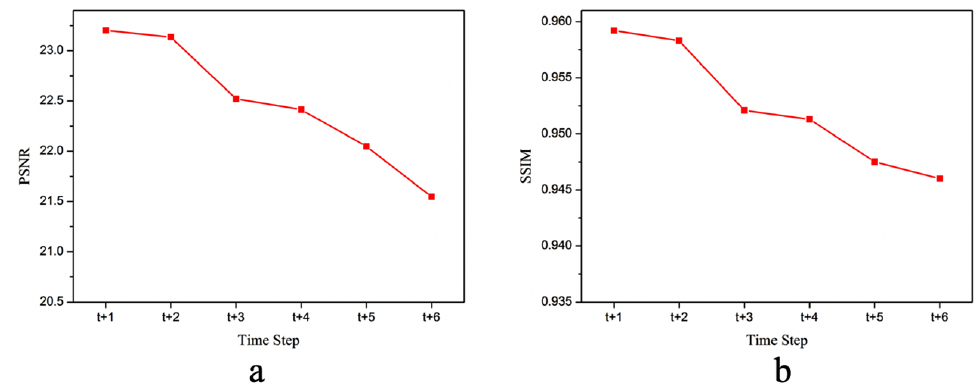
Figure 8. Line plots showing the results of evaluation metrics at each time step. ( a ) PSNR. ( b ) SSIM. Arabidopsis thaliana Root